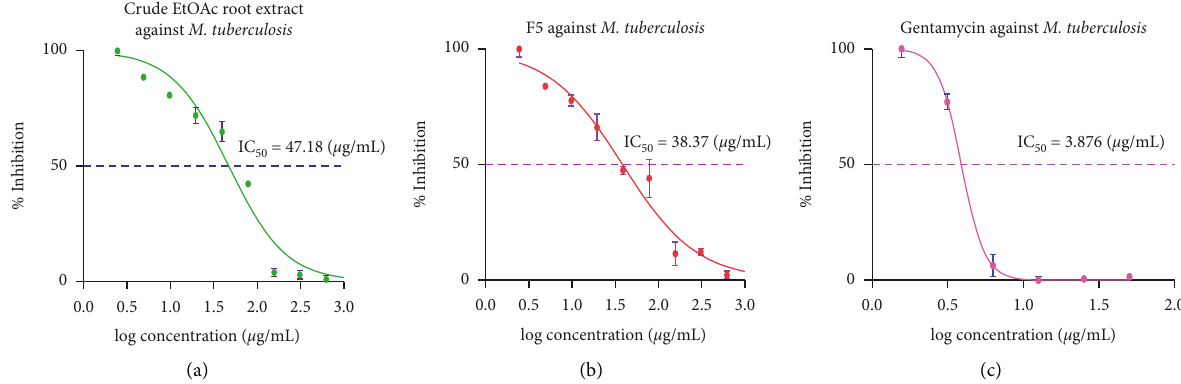
Figure 5: Dose-response curves for (a) crude EtOAc extract, (b) EtOAc fraction F5, and (c) Gentamycin against M. tuberculosis